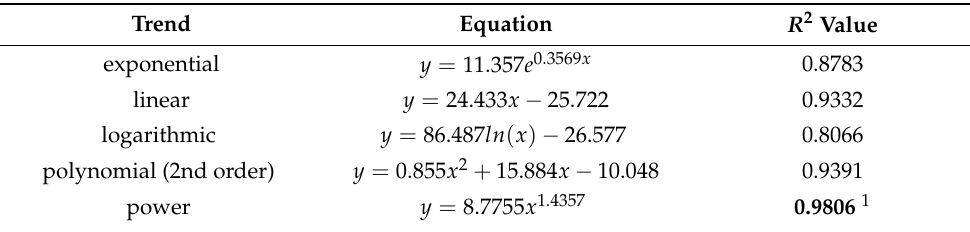
Table 3. Equations of trendlines for the Scopus dataset corresponding to the expression “big data mining” (for the years 2012–2020).